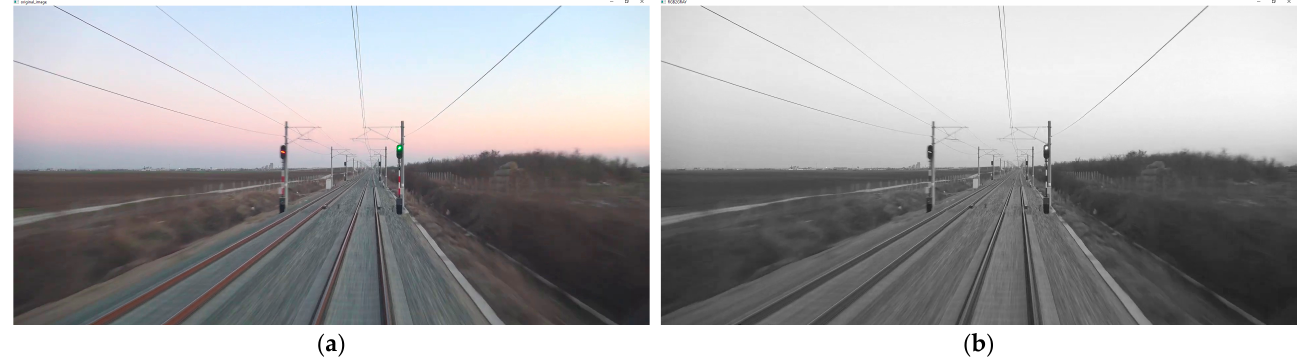
Figure 3. Railway infrastructure (Novi Sad–Belgrade route). ( a ) Original image; ( b ) grayscale image.